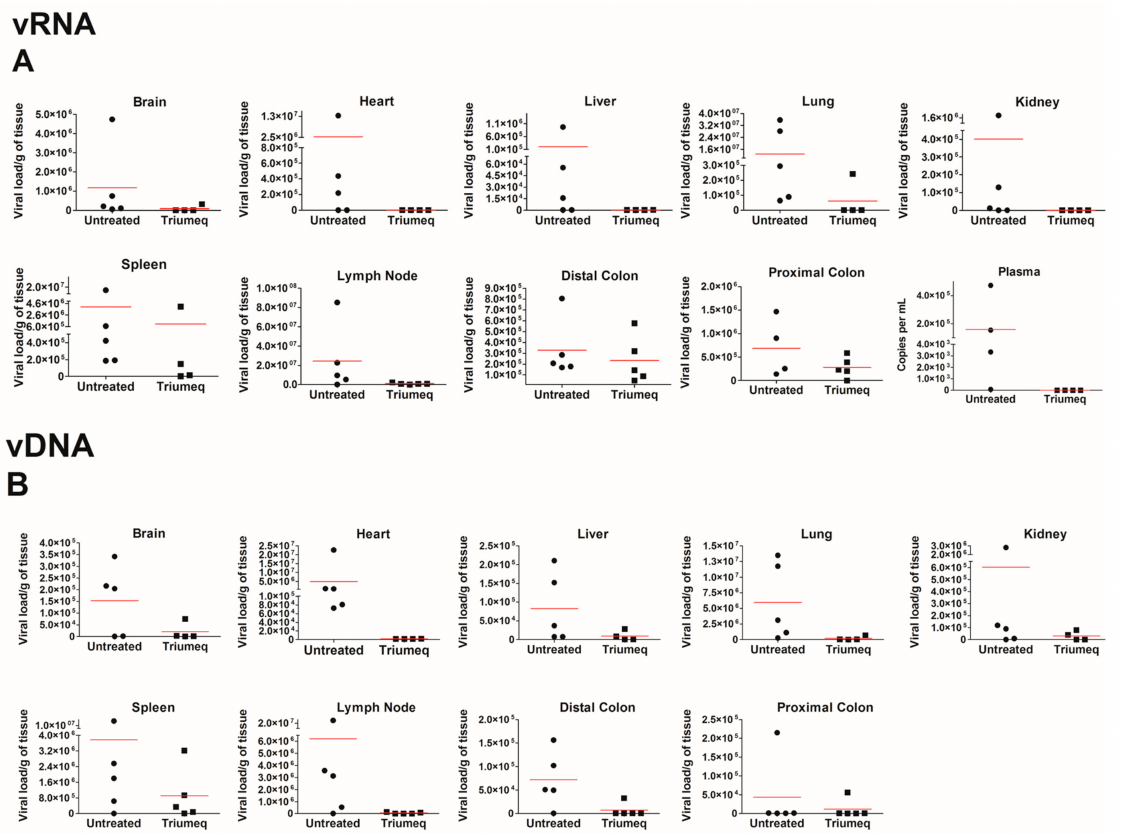
Figure 3. ARV chow reduces the HIV RNA and DNA in peripheral tissues. Brain, heart, liver, lungs, kidneys, spleen, lymph nodes, proximal colon, distal colon and plasma from HIV-infected hu-PBMC-NSG mice treated with ARVs for 4 weeks were isolated and the viral load was determined from ( A ) the isolated RNA and normalized to grams of tissue. The undetermined values were set to a CT of 45. ( B ) The vDNA isolated from different tissues and normalized similarly. Untreated mice are represented by closed circles • , while Triumeq treated are represented by closed squares (cid:4)